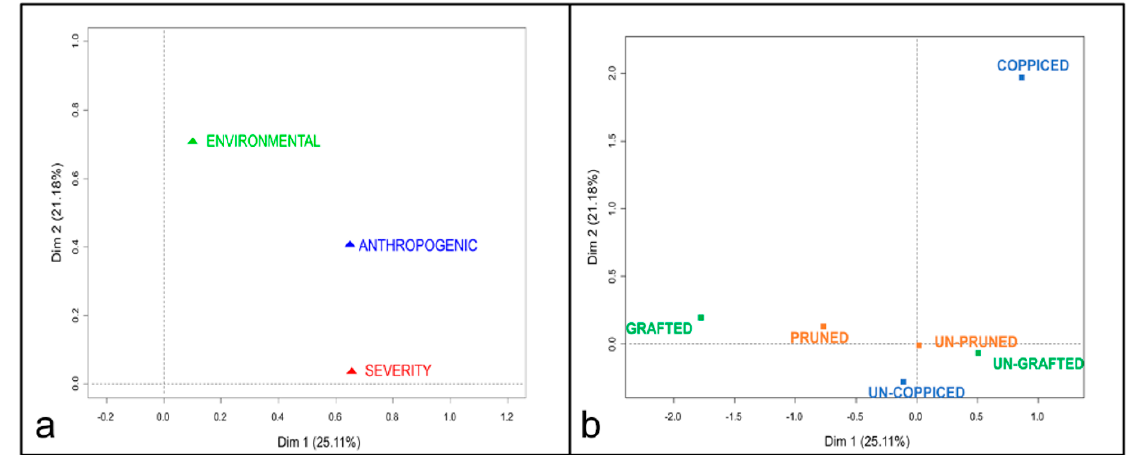
Figure 3. ( a ) Results of multiple factor analysis of all factors, with the central position of three factor groups shown; ( b ) Results of multiple factor analysis, with the poles of binary anthropogenic factors shown.